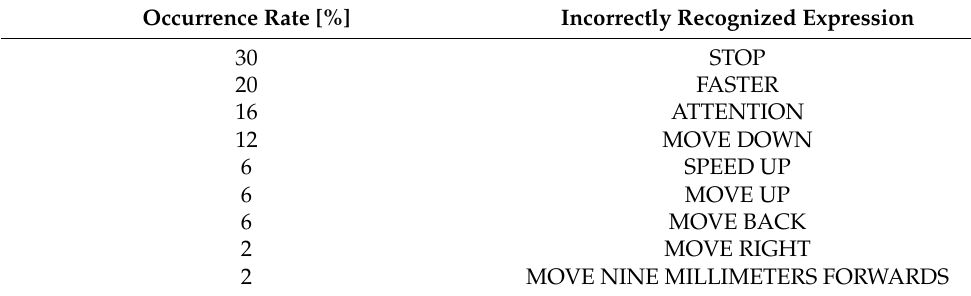
Table 4. Incorrectly recognized expressions sorted by occurrence rate. Occurrence Rate